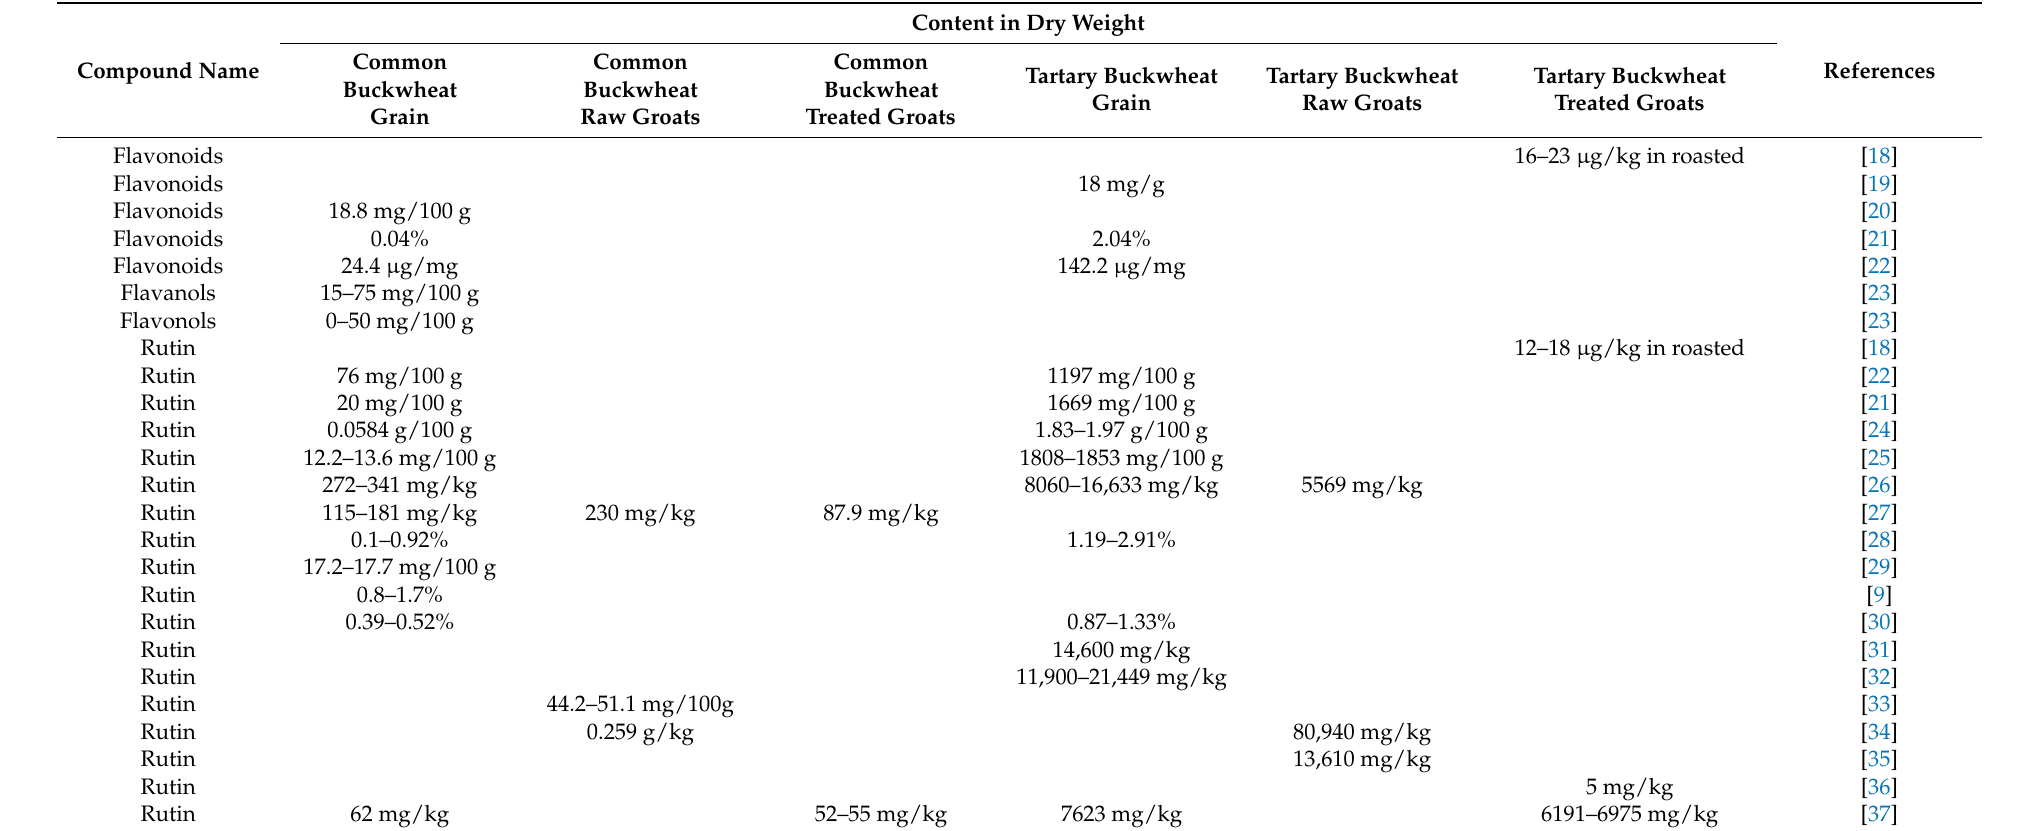
Table 1. Content of major bioactive compounds isolated from buckwheat grain and